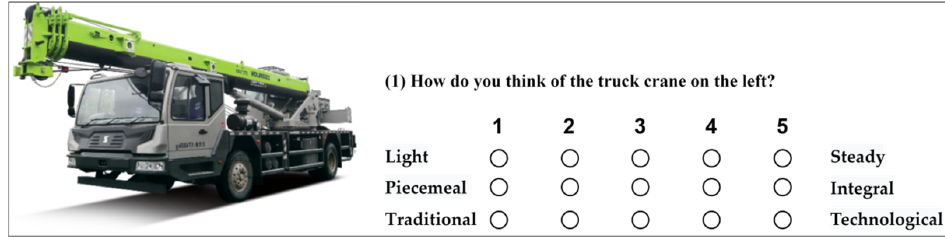
Figure 4. Excerpts from the questionnaire of truck-crane perceptual image evaluation.